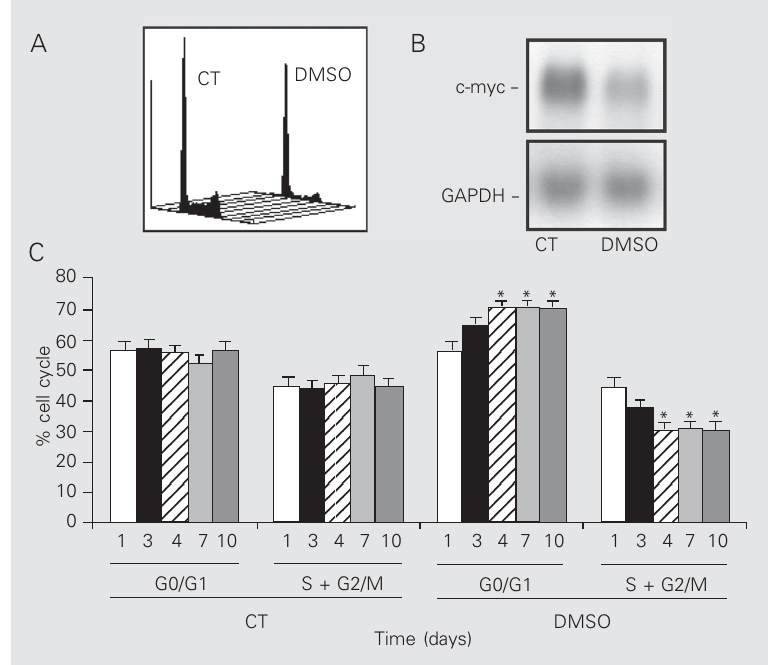
Figure 1. Dimethyl sulfoxide (DMSO, 2.5%, v/v) inhibits LISP-1 proliferation. A , DNA quantification in control cells (CT) and in cells exposed to DMSO for 10 days. B , c-myc mRNA and GAPDH bands were obtained by Northern blot. C , G0/G1 and S + G2/M, as percent of cells (y-axis), were obtained on different days of DMSO exposure (x-axis). Data are the mean ± SD obtained for 7 independent experiments. GAPDH = glyceraldehyde-3- phosphate dehydrogenase. *P < 0.05 compared to control